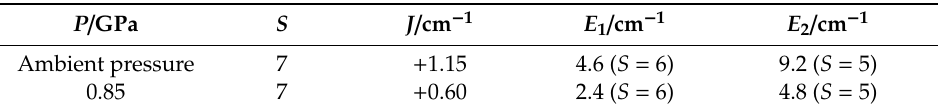
Table 3. Comparison of the J values and the energy di ff erences between the ground state and first / second excited spin states at ambient pressure and at 0.85 GPa for complex 3 as calculated from an isotropic fit of the susceptibility